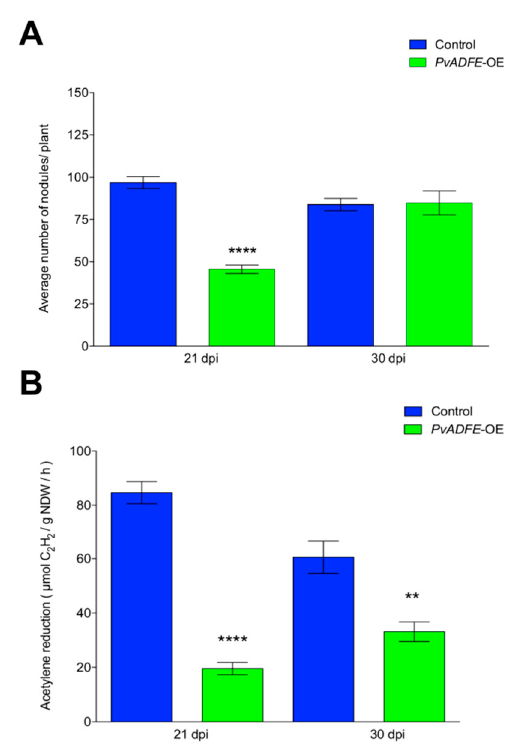
Figure 7. Nodulation and nitrogen fixation capacity of PvADFE -OE and control transgenic roots. ( A ) Nodules were collected and counted from control and PvADFE -OE transgenic roots inoculated with R. tropici CIAT-899 at 21 and 30 dpi. ( B ) Nitrogenase activity determined by the acetylene reduction assay in control and PvADFE -OE nodules of transgenic roots at 21 and 30 dpi. NDW: Nodule dry weight. Bars represent mean ± SEM for three biological replicates with n > 7. ** p < 0.005 and **** p < 0.0001 according to Student’s t- test.